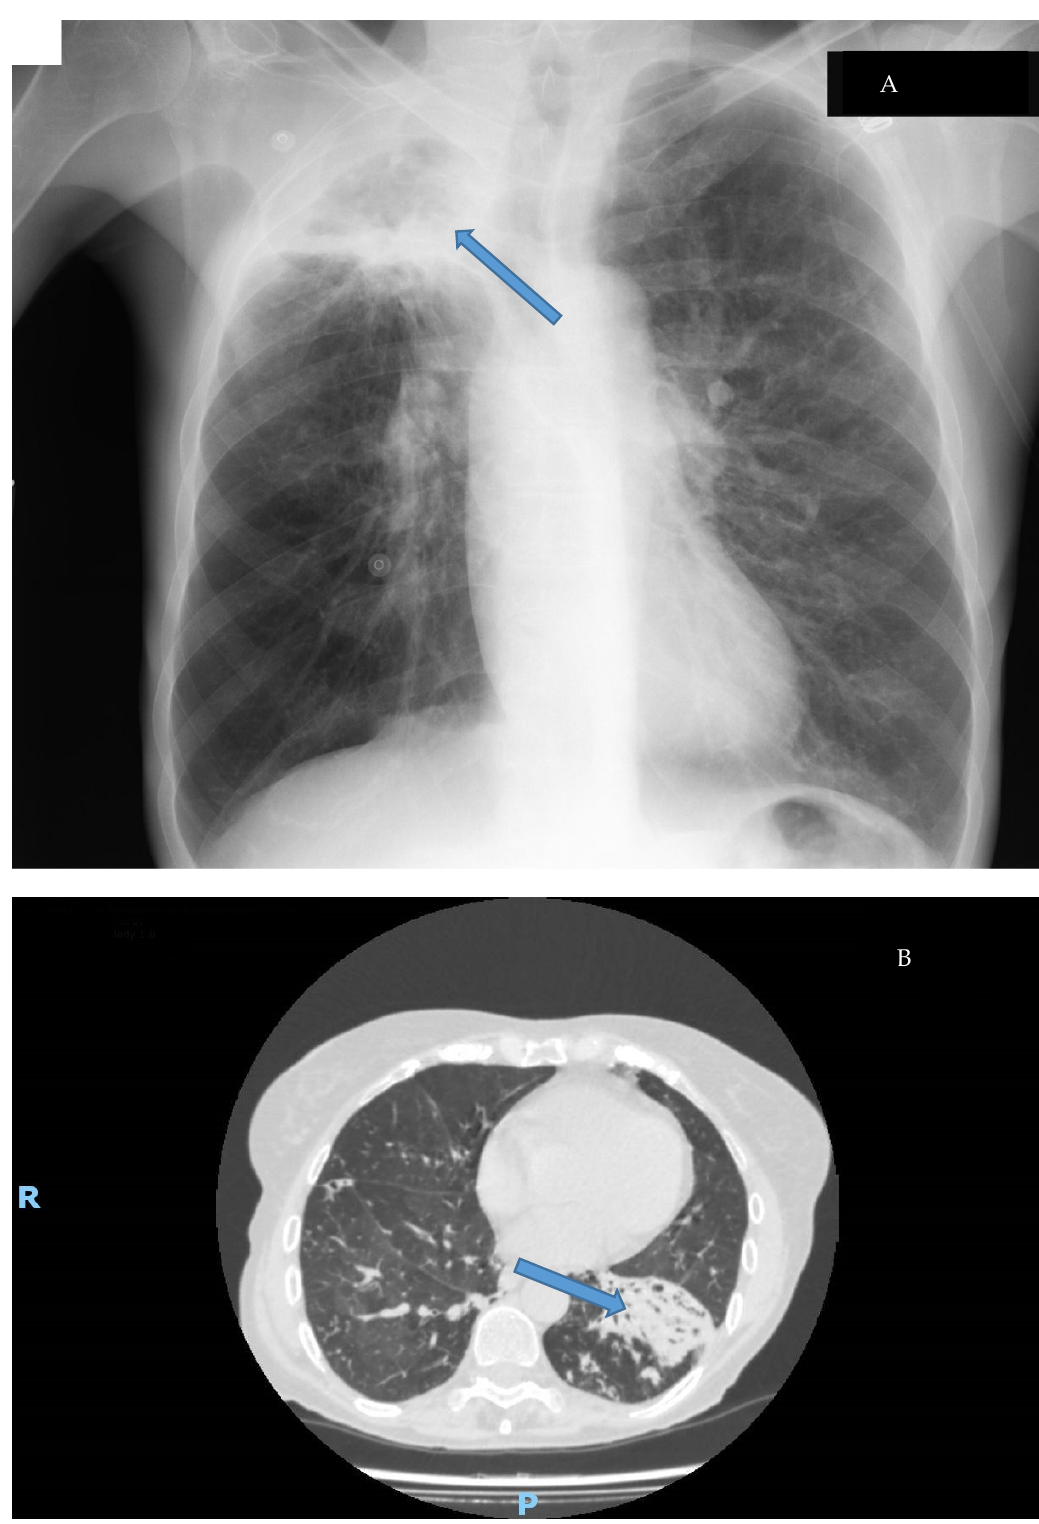
Figure 4. Types of lung disease caused by M. abscessus : ( A ): Cavitary disease (cavitation in the upper lobe of the right lung Thoracic X-ray); ( B ): Fibronodular disease (alveolar infiltrates with bronchiectasis in CT-Scan). Disease is signaled by an arrow.